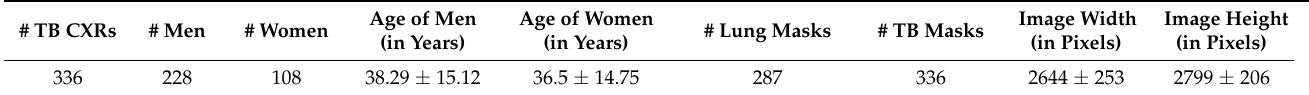
Table 1. Dataset characteristics. The age of the population of men and women, image width, and image height are given in terms of mean ± standard